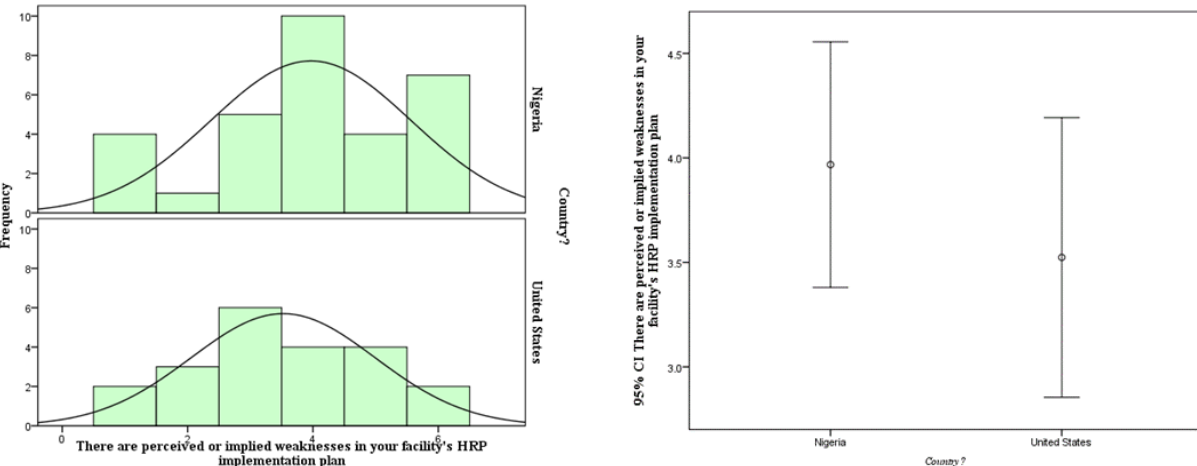
Figure 10. Perceived or implied weaknesses in your facility’s